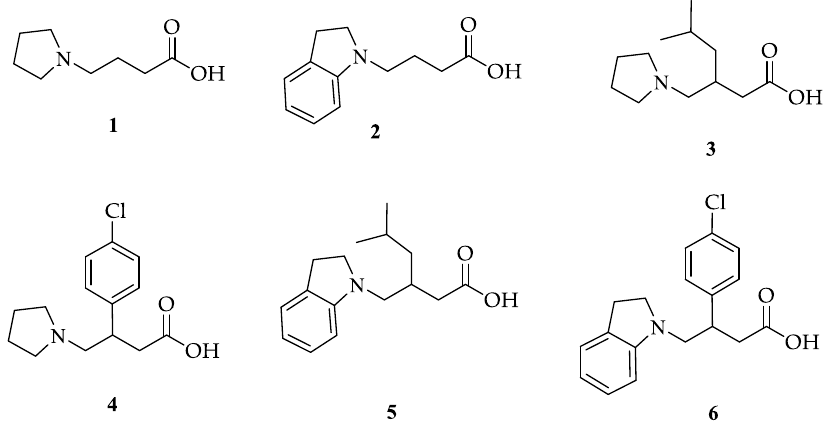
Figure 1. Pyrrolidine and indoline GABA analogues.